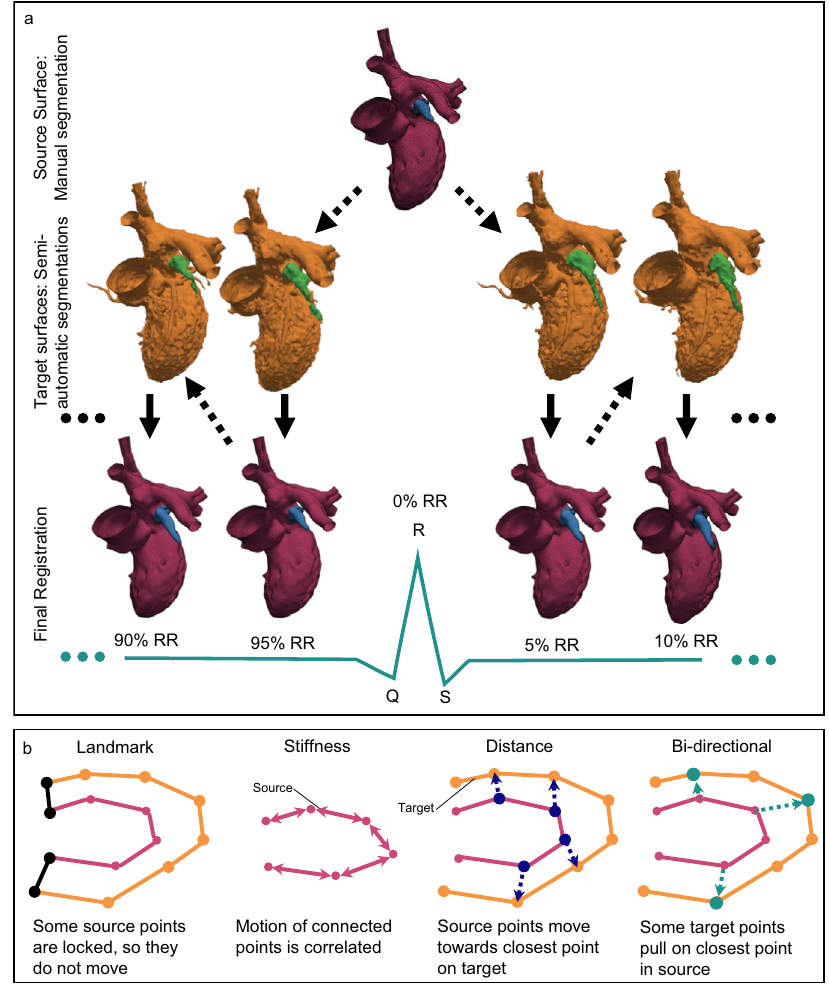
Fig. 1 Registration Work fl ow. a The Source surface at 0%RR was registered onto the target surfaces at 5%RR and 95%RR. The resulting fi nal registrations were then registered onto 10%RR and 90%RR, respectively. The surface of the LAA (marked blue and green) was registered separately. b The registration was driven by four different terms: Landmark, Stiffness, Distance and